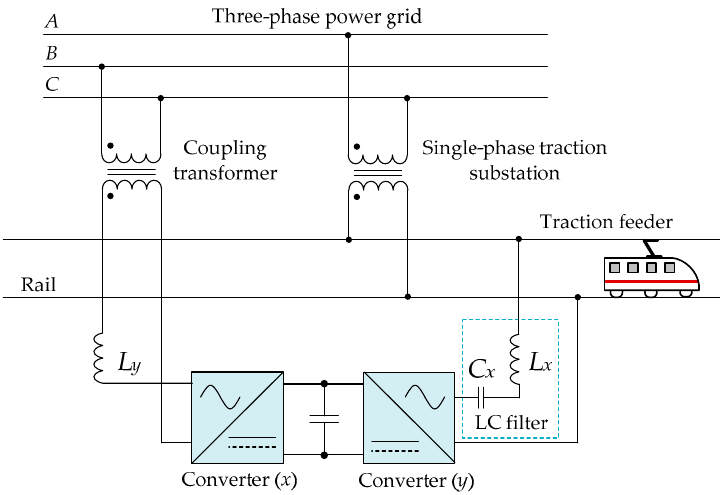
Table 9. Components quantities of the co-HRPC.